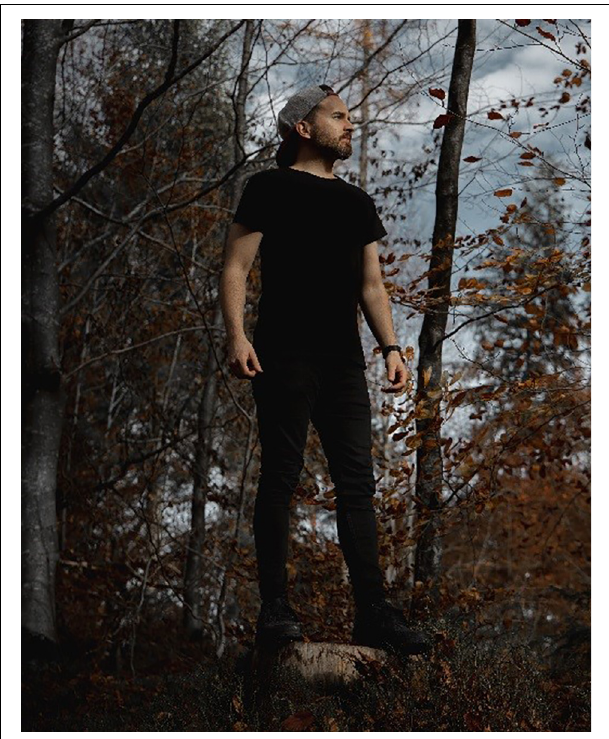
FIGURE 6 | Explorer pose (source: Instagram/©@simon_kmyr).